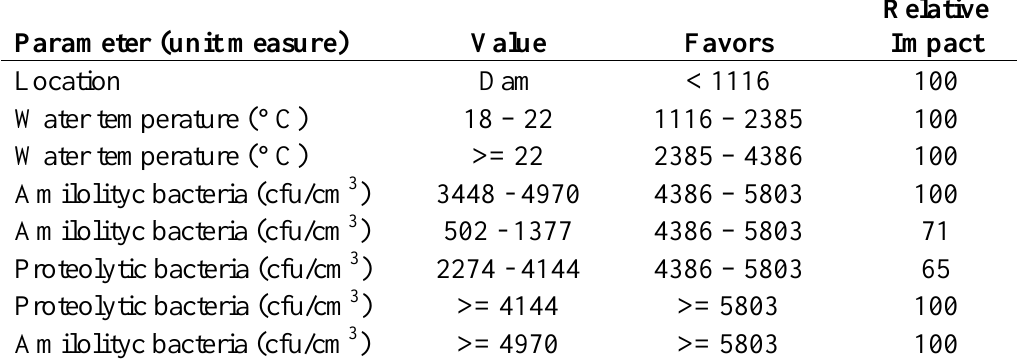
Table 4. Key Influencers Report and their impact over the values of total zooplankton (ind/dm 3 ) without zooplankton groups and species for the Gruža